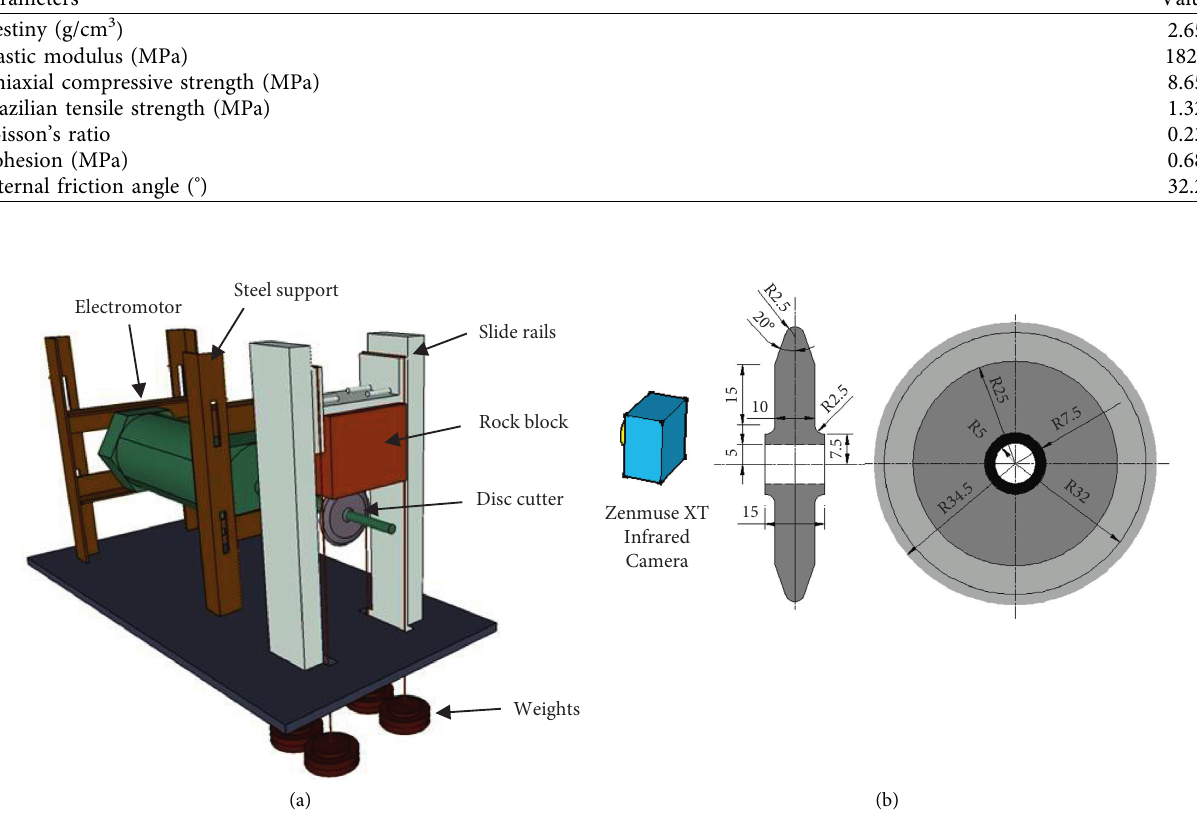
Figure 2: Schematic diagram of cutter rotary indentation tests. (a) Test bench; (b) the size of reduced scale disc